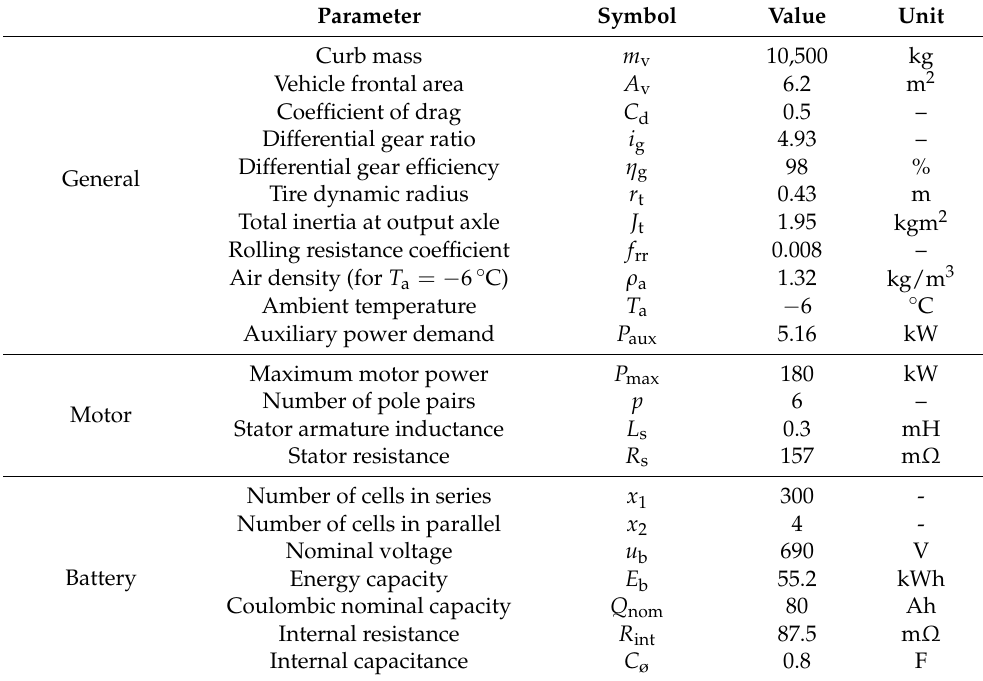
Table 3. Parameters of the battery electric bus model